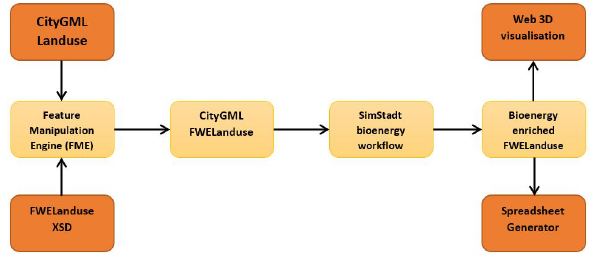
Figure 11. The the use of FWELanduse with SimStadt’s bioenergy workflow